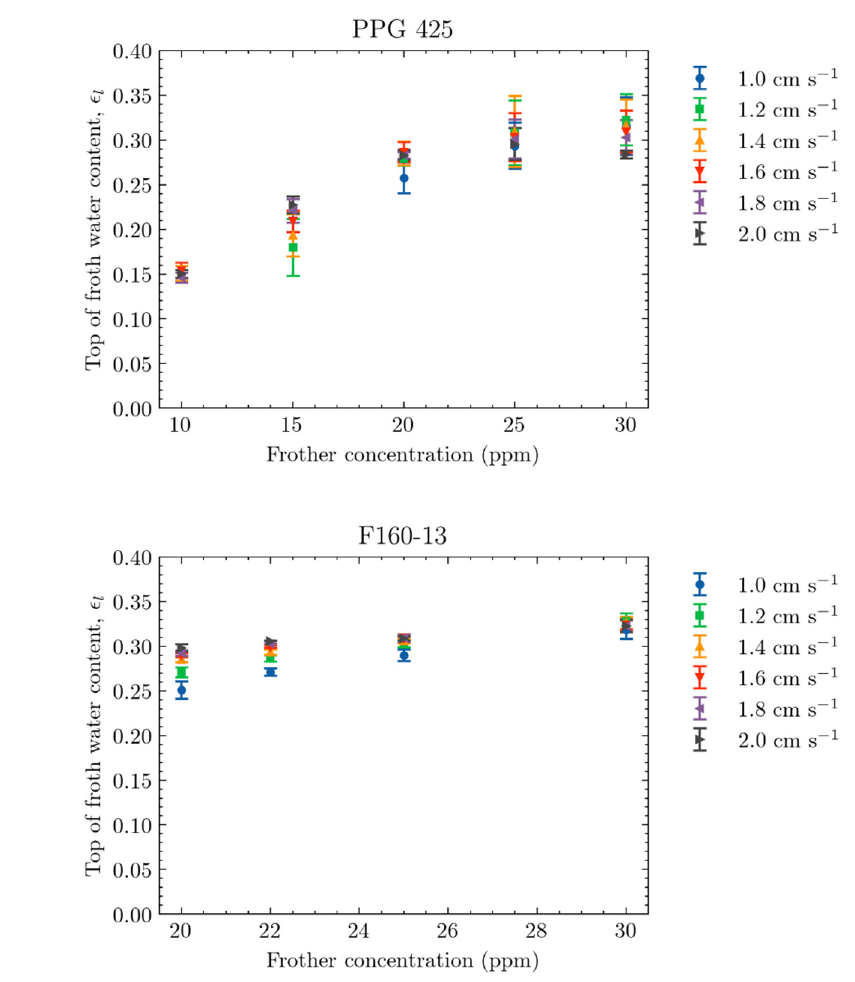
Figure 7. Measured froth water content under various operating conditions for ( a ) DF1012, ( b ) PPG 425 and ( c ) F160-13, at various input air rates.